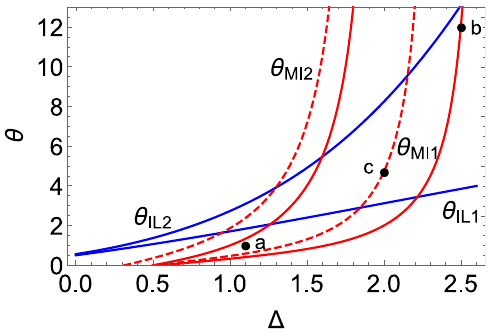
Figure 3: Critical values of the parameter θ as functions of Δ for the Hopf instability (blue) and for the modulational instability (red), for G = Δ (solid red lines) and G = Δ + 1 (dashed red lines). The points marked as a , b , and c correspond to the parameters used in the numerical simulations, with G = Δ for a and b , and G = Δ + 1 for c . In the region below the blue curves (point a ), the lower branch is unstablebecauseitisbelowtheinjectionlockingpoint.Intheregion betweenthem(points b and c ),thelowerbranchofthe S hasastable portion. In the region between the red curves, the bifurcation point MI of the modulational instability is placed in the upper branch between the two turning